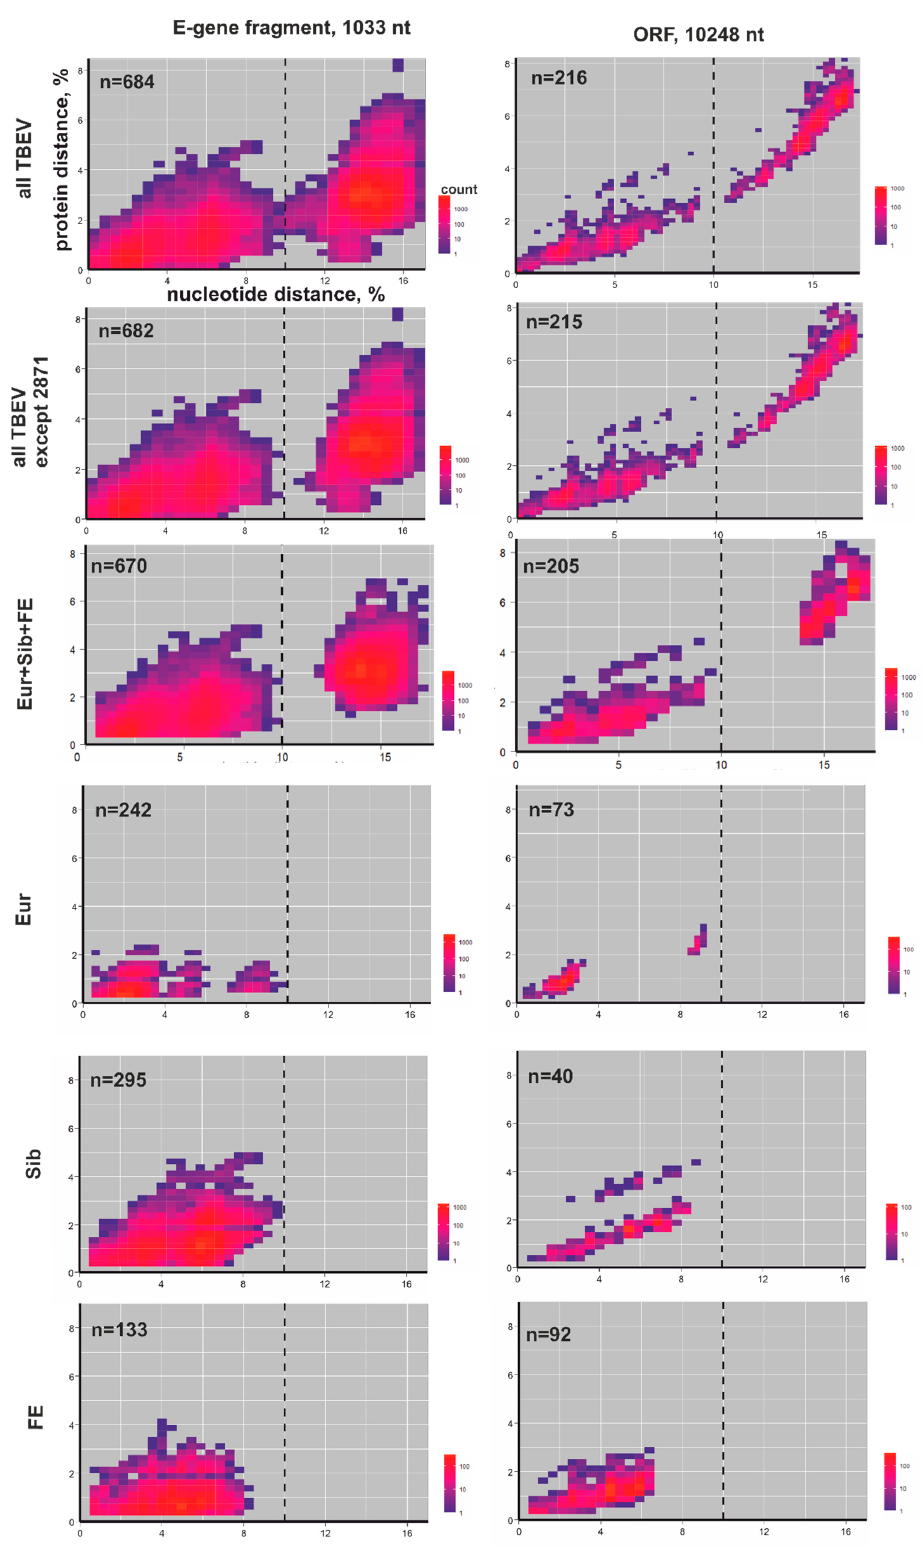
Figure 2. Heatmap of concordance between nucleotide and amino-acid pairwise distances in E gene fragments (left panels) and ORF (right panels). First panel: all TBEV sequences. Second panel: all